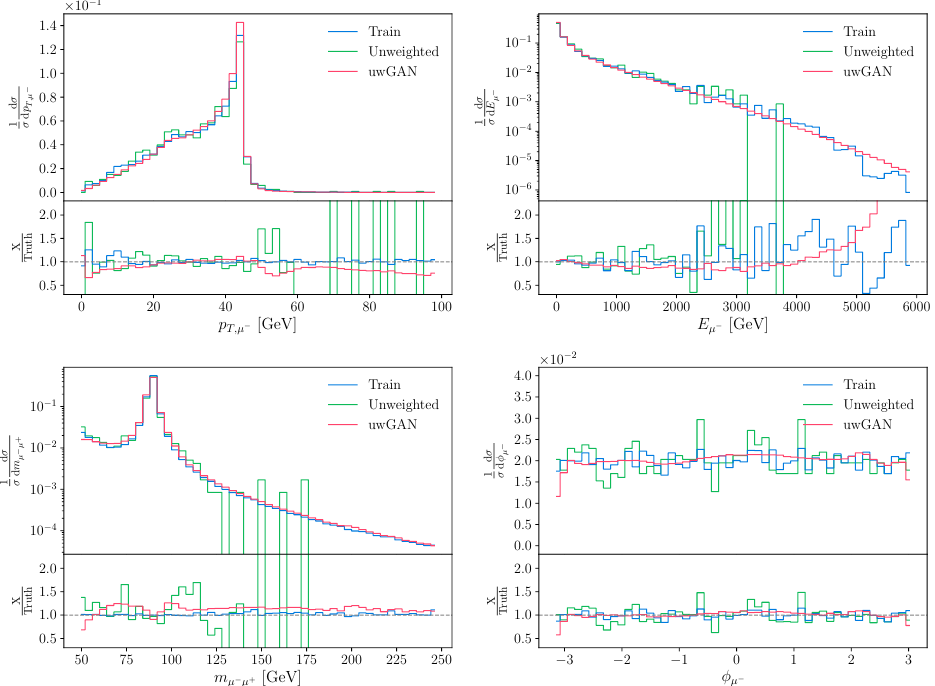
Figure 5: Exemplary kinematic distributions for the Drell-Yan process. For the kine- matic distributions we show the 500k weighted training events, 1k unweighted events using the standard unweighting algorithm discussed in Sec. 2.1, and 30M uwGAN